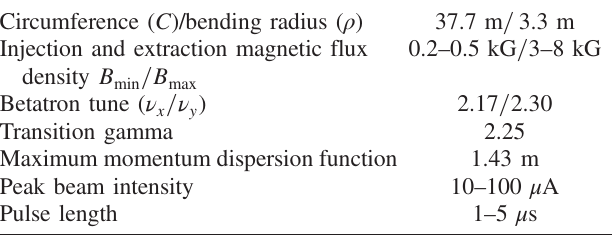
TABLE I. Device and beam parameters.